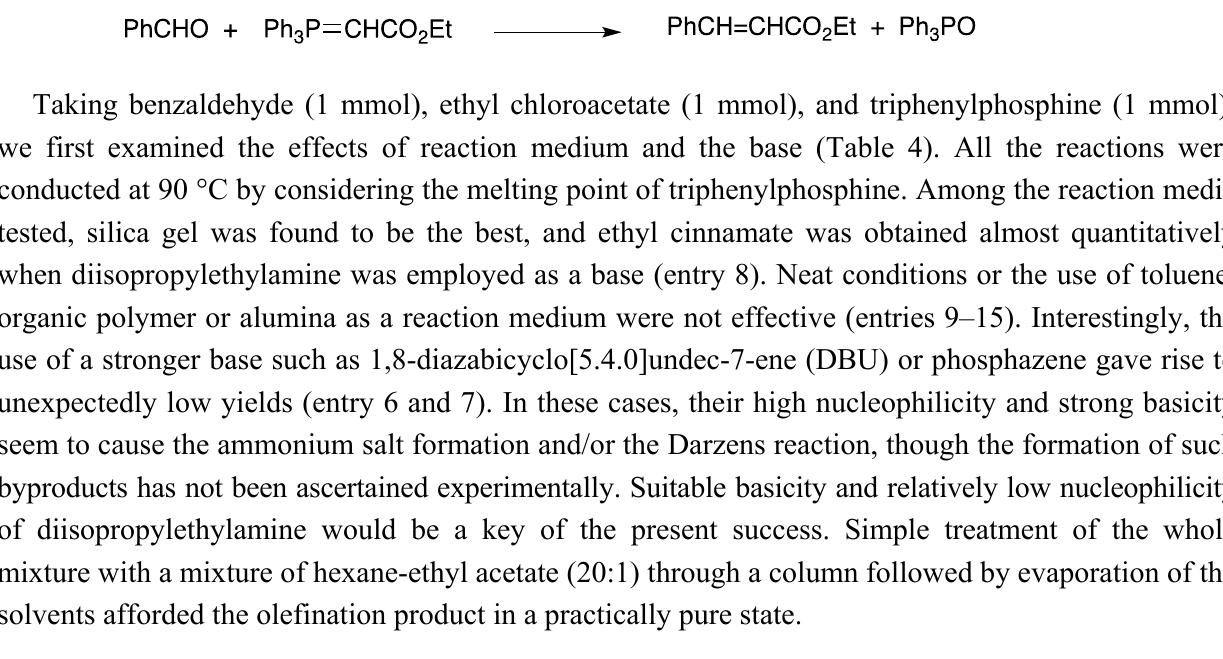
Table 4. One-pot Wittig-type olefination of benzaldehyde under various conditions a .